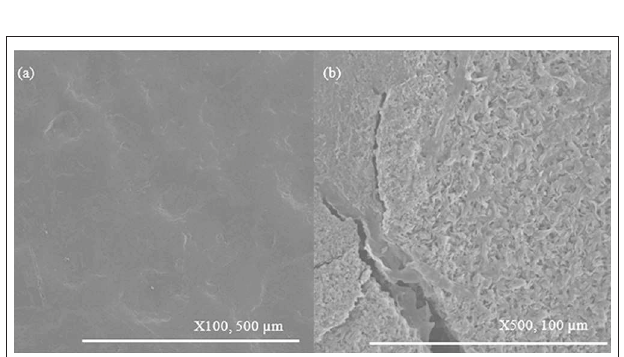
FIGURE 14 | SEM images of key changes in samples after 112 days. (a) HIPS remains unchanged; (b) pitting becomes continuous for all other samples.